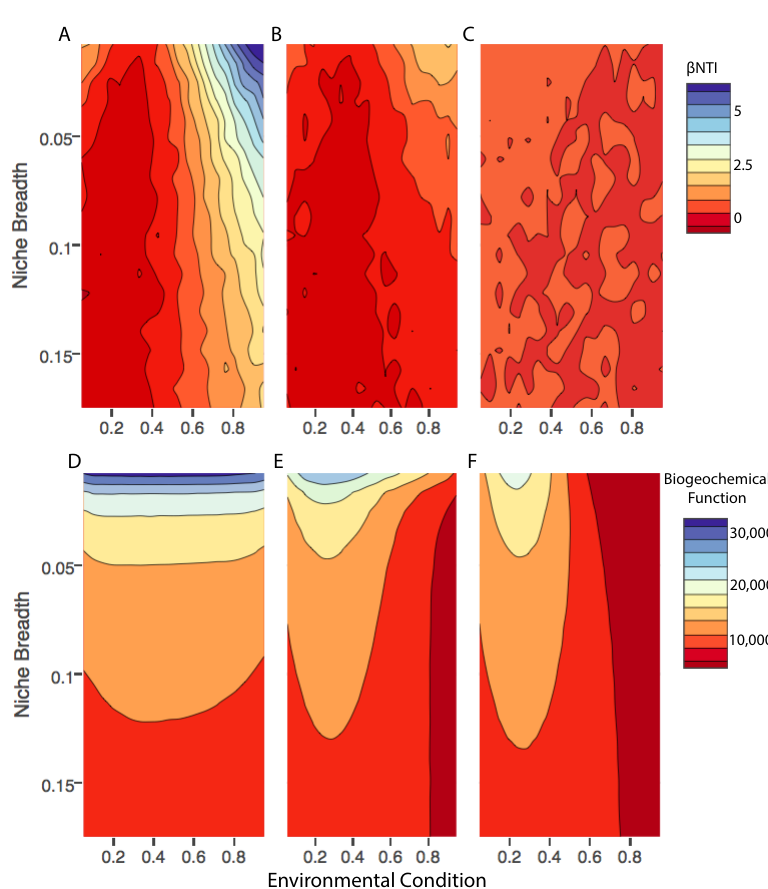
Figure 6. Interpolated contour plots showing average β NTI ( A – C ) and biogeochemical function ( D – F ) for each dispersal case across all parameter combinations. Interpolations are based on parameter combinations at each of 20 evenly spaced values across each axis. Values of β NTI that are further from 0 indicate increasing influences of deterministic assembly (and decreasing stochasticity). ( A , D ) depict selection-only communities; ( B , E ) depict moderate dispersal communities; and ( C , F ) depict homogenizing dispersal